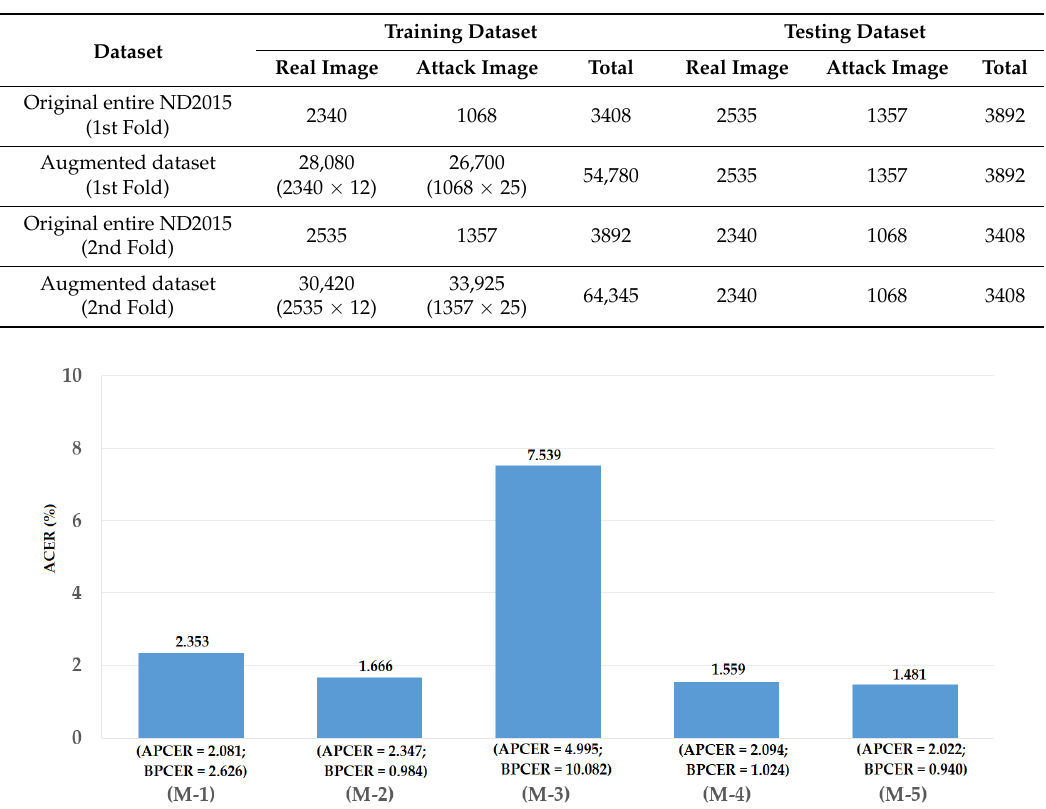
Figure 16. Detection errors of various iPAD methods using the third training-testing division method on ND2015 dataset. Note: (M-1) Using CNN as Classifier; (M-2) Using CNN Features with PCA